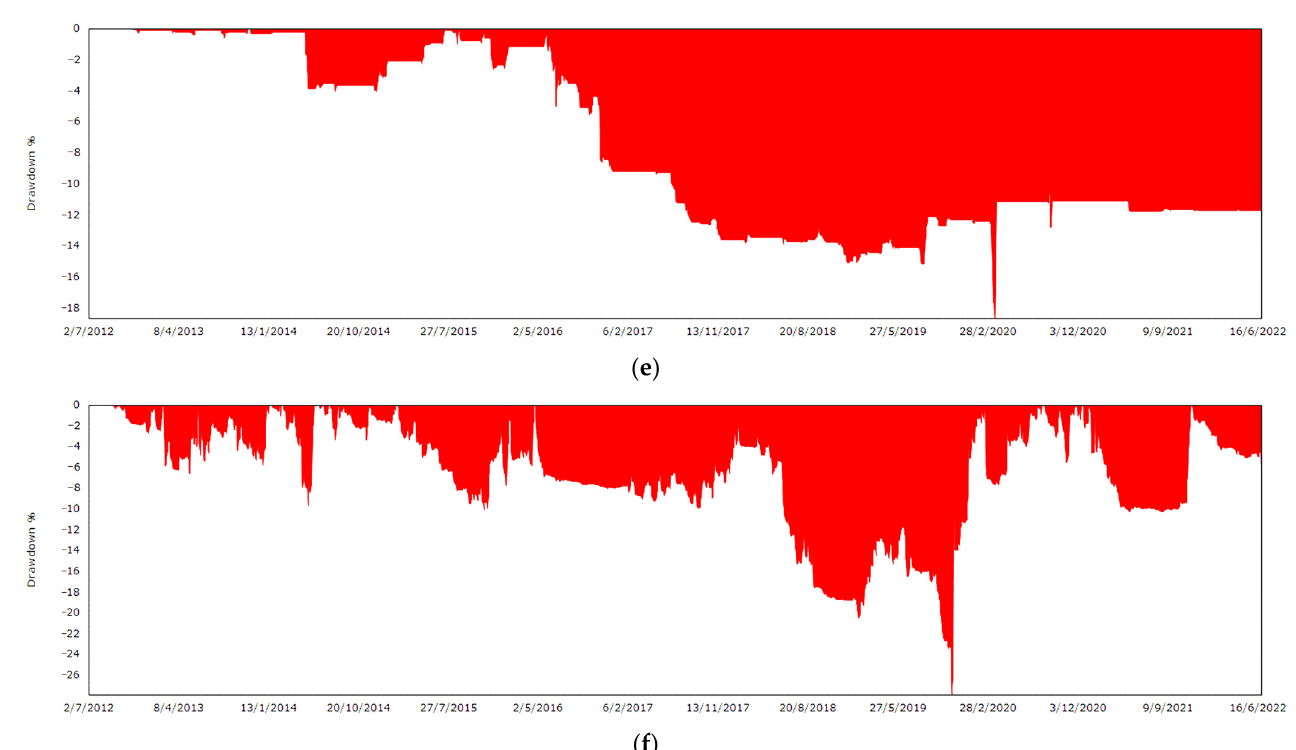
Figure 2. Drawdown (%) of the technical trading systems for the period 1 July 2012 to 30 June 2022. The y-axis shows percentage drawdown, while the x-axis shows the period. ( a ) MACD; ( b ) BB; ( c ) MACD-BB; ( d ) D-MACD; ( e ) D-BB; ( f ) D-MACD-BB.